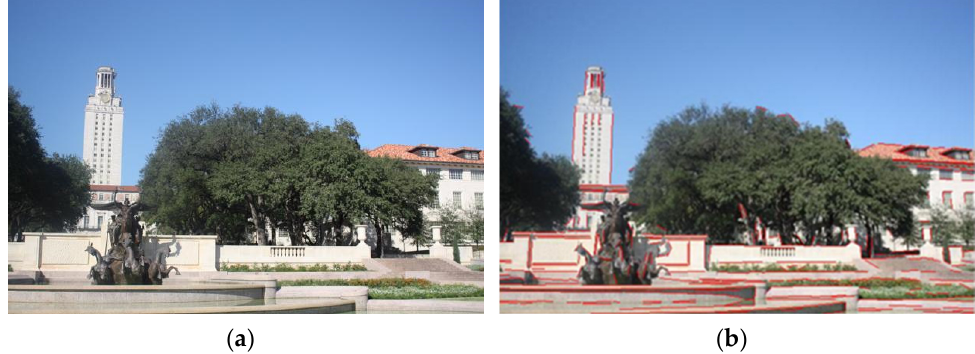
Figure 3. Extracting line features from an image: ( a ) The original image (615 × 410 pixels); ( b ) the line features extracted by LSD.